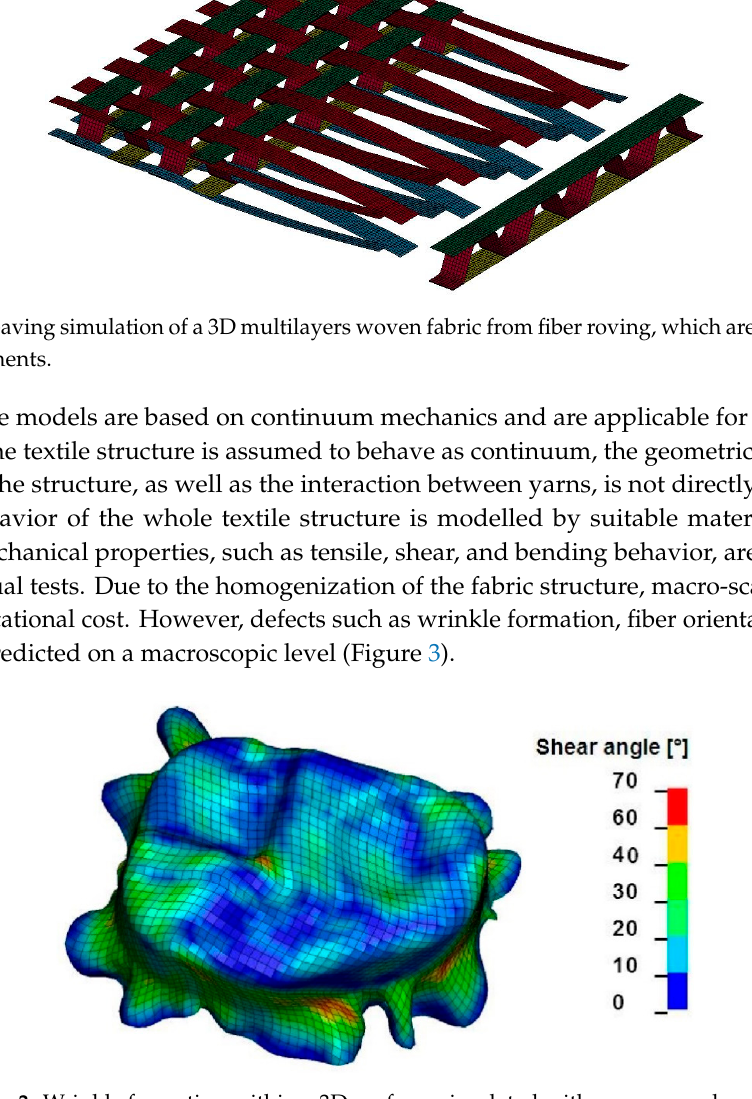
Figure 3. Wrinkle formation within a 3D preform simulated with a macro-scale model.